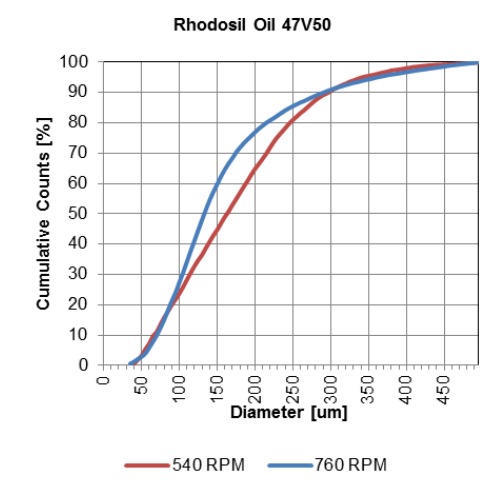
Fig. 8. Comparison of cumulative particle counts of stable dispersion of disintegrated Silicone Oil AP1000 under stirrer rate 540 rpm, and 760 rpm.